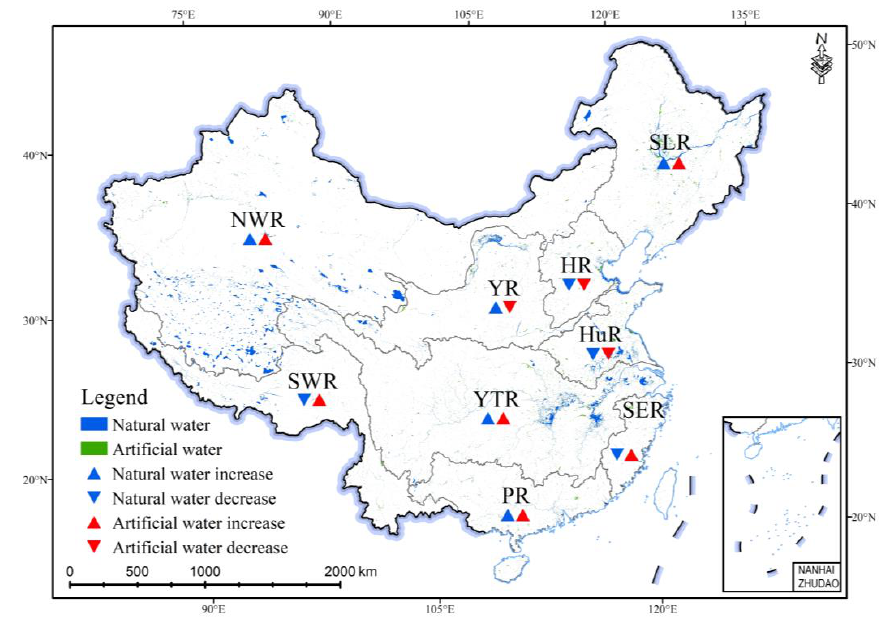
Figure 7. Spatial distribution of artificial and natural water bodies in China in 2020 and the change trend of artificial and natural water bodies in each basin from 2015 to 2020 compared with 2000 to